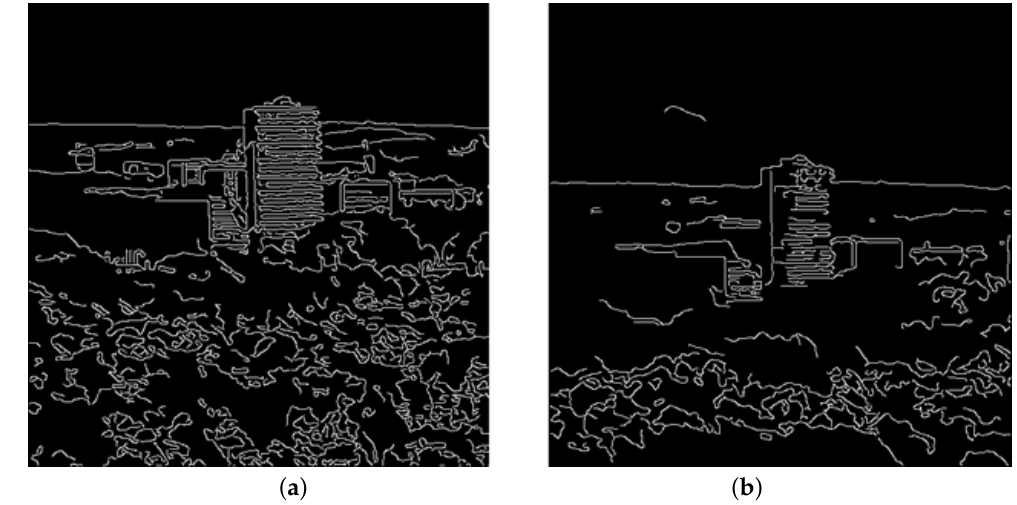
Figure 5. Separation of area contours with a Canny filter with a threshold value of 0.16 when ( a ) the sun is shining, ( b )